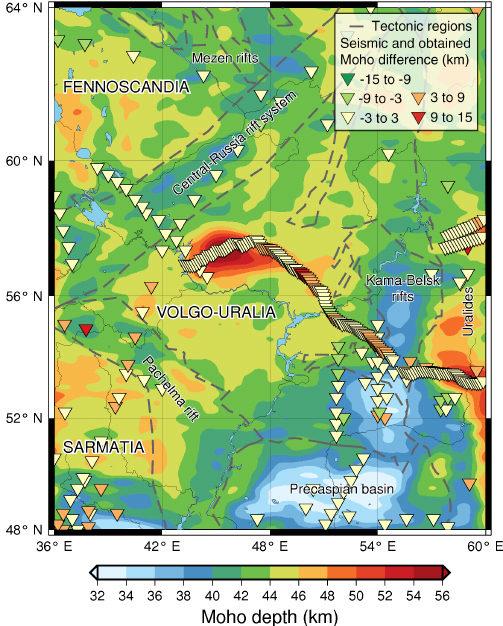
Figure 11. Moho model of Volgo–Uralian subcraton obtained through the gravity inversion with laterally variable density con- trasts (Haas et al., 2020) and subsequent forward gravity modelling with seismic and gravity constraints in IGMAS + (Götze and Lah- meyer, 1988; Schmidt et al., 2020). The comparison between the model which was obtained in the process of gravity inversion and the IGMAS + Moho model is shown in Fig. S3 in the